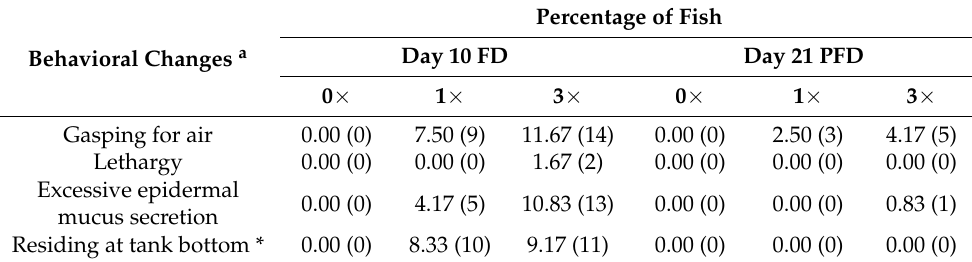
Table 2. Visual characterization of behavioral abnormalities in Oreochromis niloticus juveniles upon di- etary administration of florfenicol at 0–3 times the therapeutic dose ( 1 × : 15 mg kg biomass − 1 day − 1 ) for 10 consecutive days in comparison to the